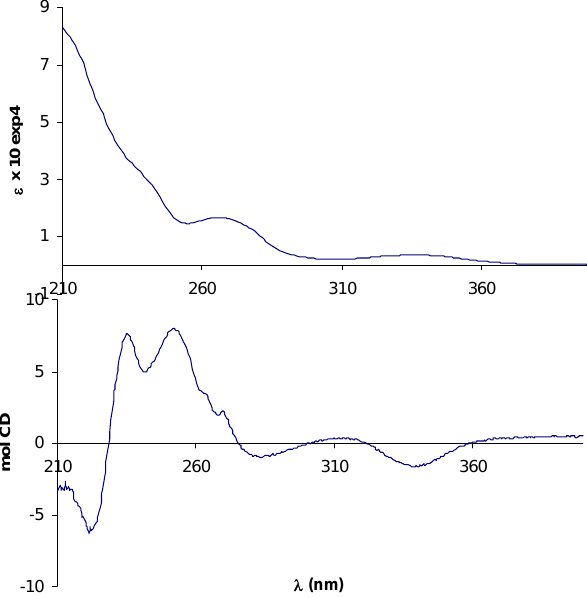
Figure 2. Electronic (up) and CD (bottom) spectra of free ligand (+)- 9 in CH 3 CN.